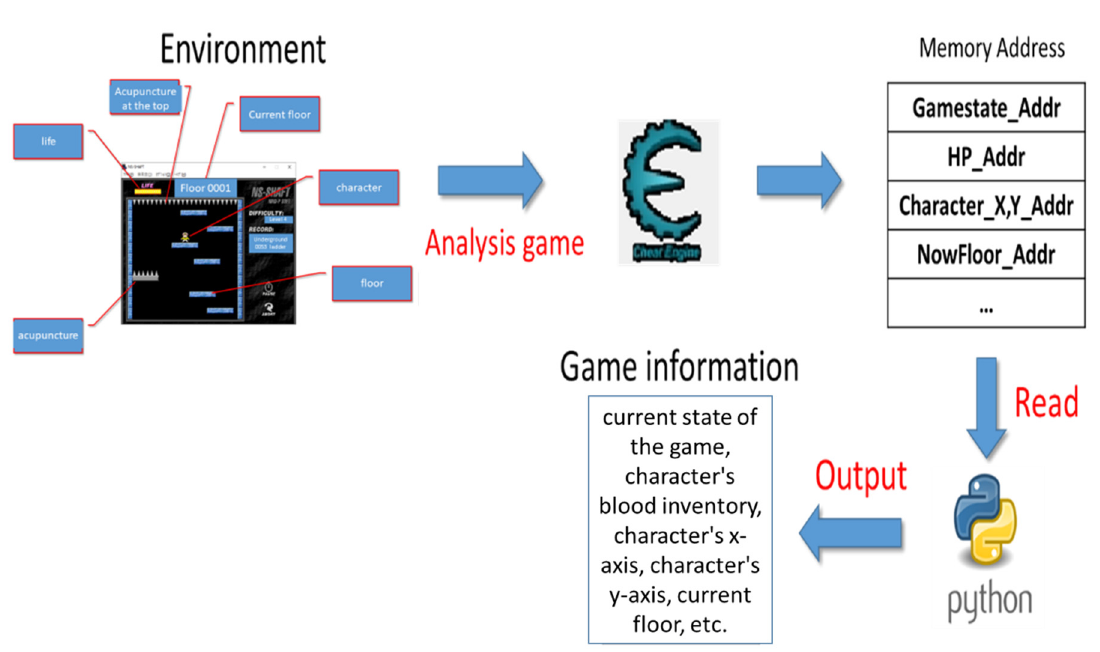
Figure 6. The flowchart of obtaining game internal information.